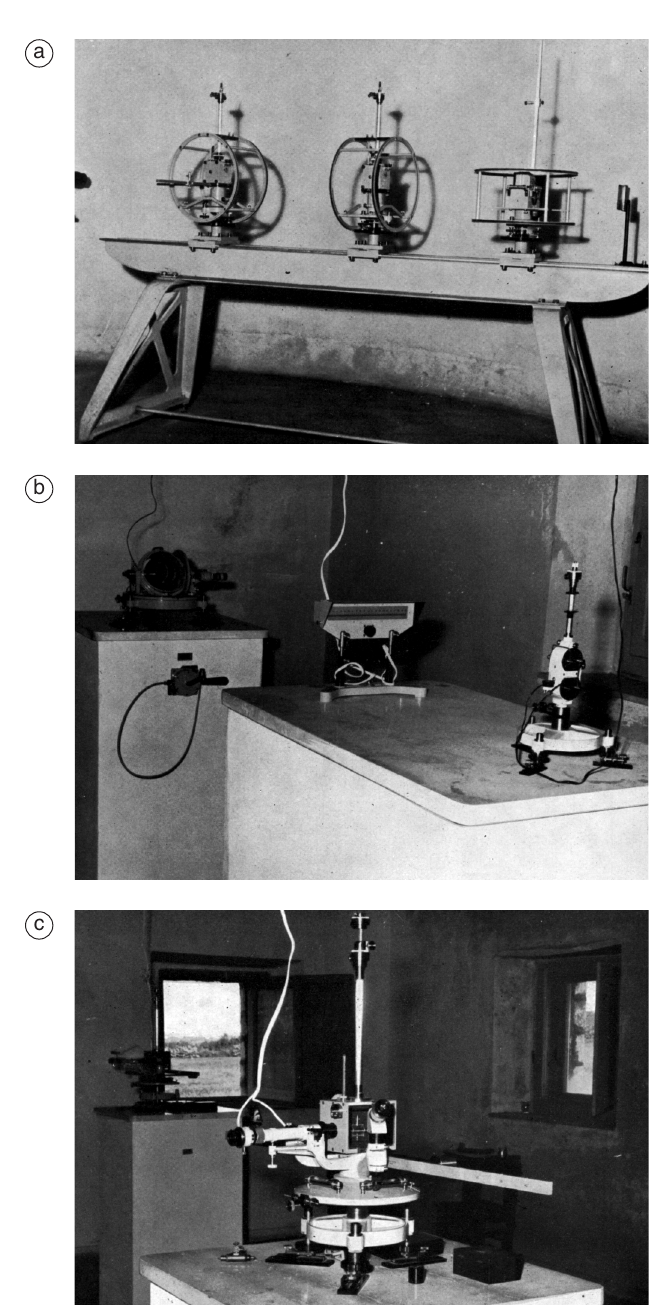
Fig. 1a-c. From the top: a) Ruska Magnetic Variograph ensamble, b) Ruska Earth inductor and c) Ruska Mag- netic Theodolite, all at L’Aquila (1958) (from: Istituto Nazionale di Geofisica,